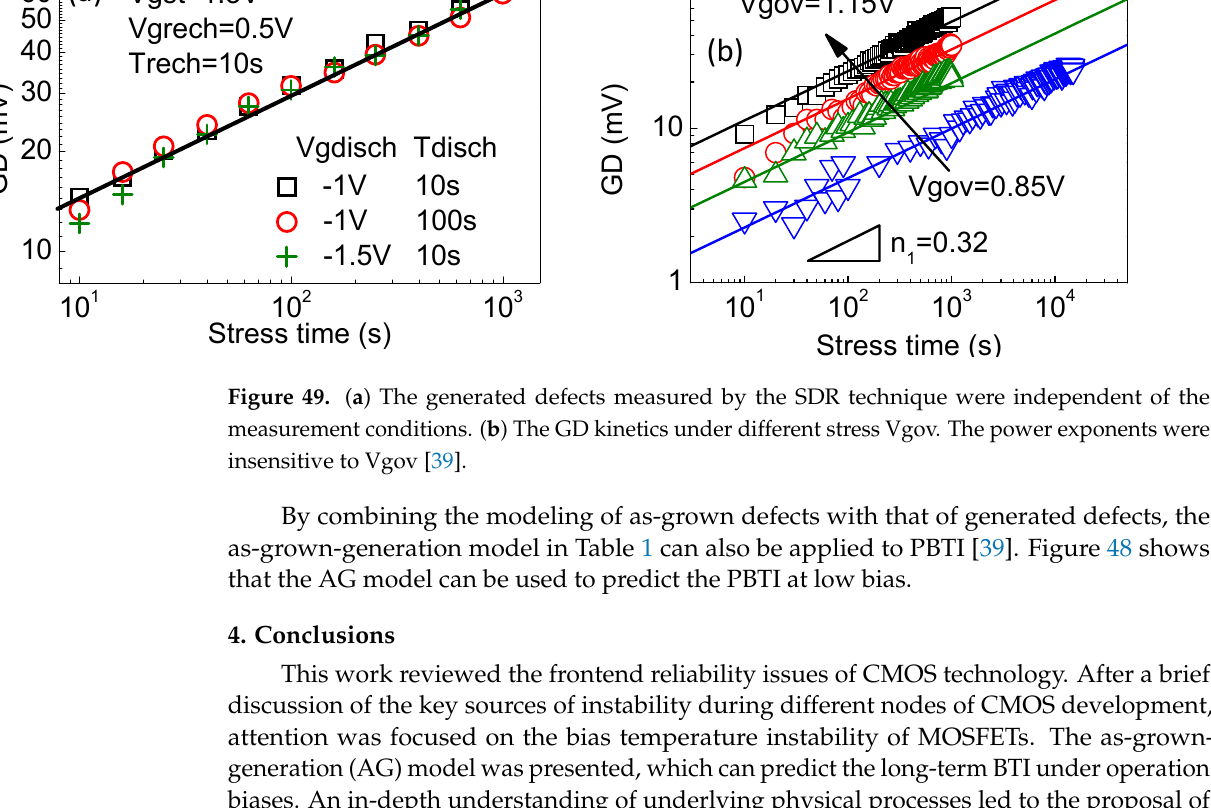
Figure 48. The AG model extracted from the accelerated PBTI tests can predict the PBTI at low biases, while the power law directly fitted with the same test data overestimates PBTI lifetime by 4 orders of magnitude [39].